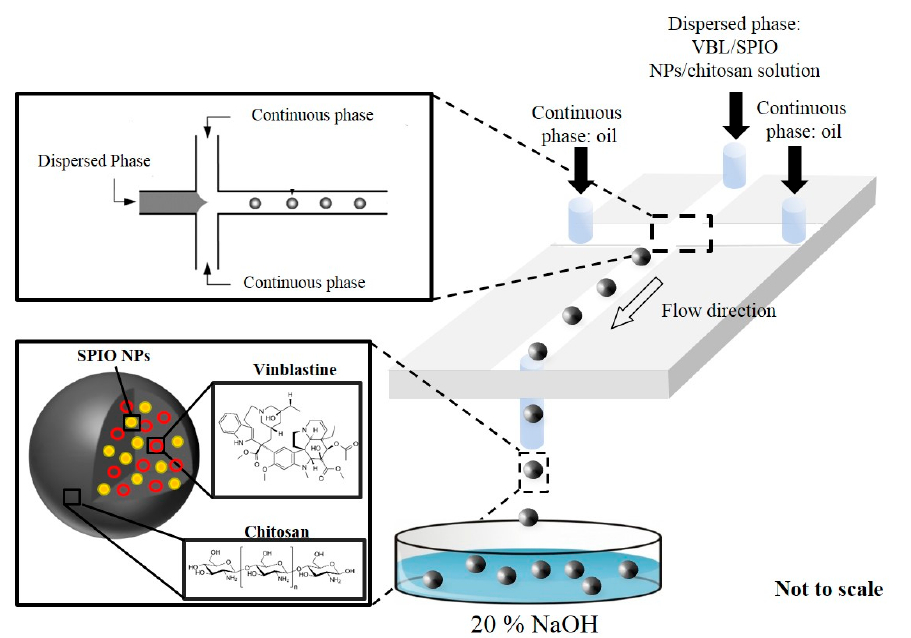
Figure 2. Schematic diagram of the composite polymer particles preparation by a microfluidic channel device. The VBL-loaded SPIO NPs–chitosan emulsions were typically generated in a cross-junction microchannel; the emulsions/droplets were subsequently transported to a 20% NaOH solution through the microchannel. After solidification, VBL-loaded SPIO NPs–chitosan particles were obtained.